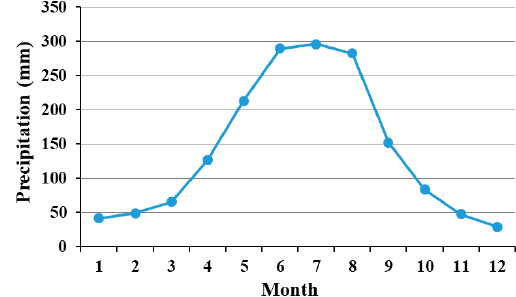
Fig ure 2. Average monthly precipitation in 1961 – 2016 in the Beibu Gulf. Figure 2. Average monthly precipitation in 1961–2016 in the Beibu